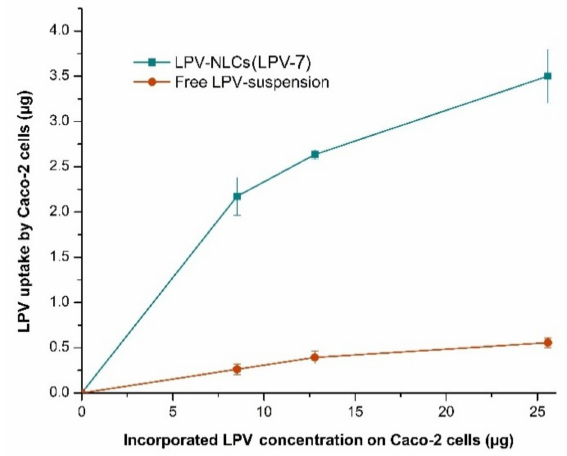
Figure 8. Comparison of LPV cellular uptake from LPV-NLC-7-Tres and LPV-suspension in Caco-2 cells. Mean ± SD, n = 3.